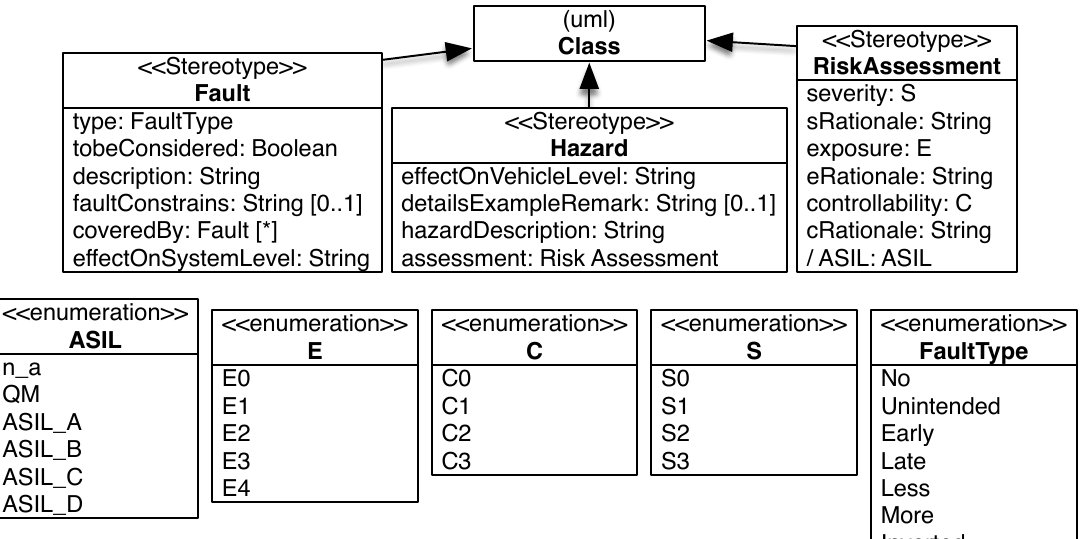
Figure 2. Fault, Hazard, Assessment based on